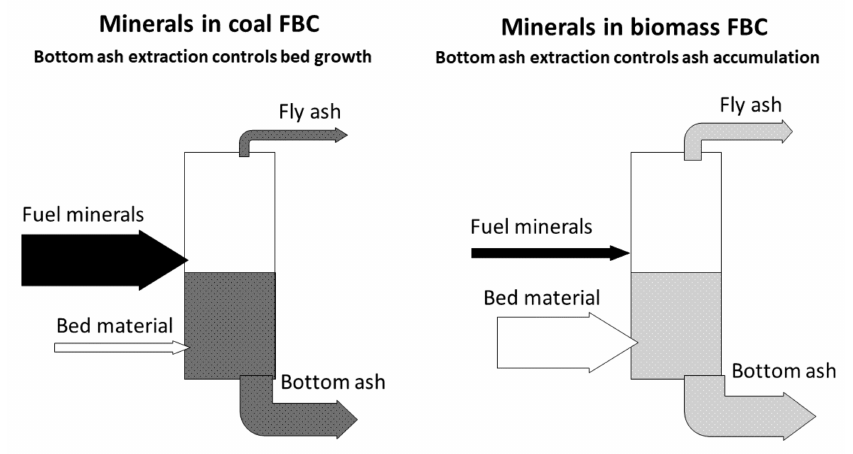
Figure 3. Schematic representation of the mineral balance over coal and biomass-fired FBC